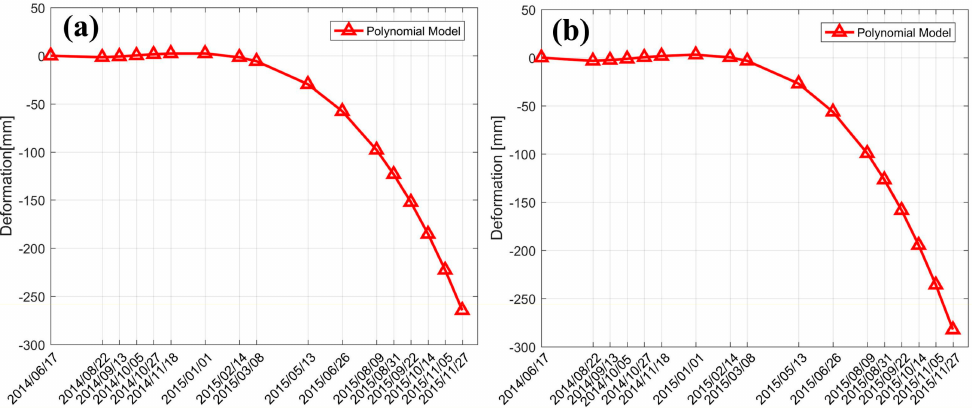
Figure 11. Low pass (LP)-deformation of the two feature points, derived from a polynomial model: ( a ) CT1 and ( b ) CT2 (with reference to 17 June